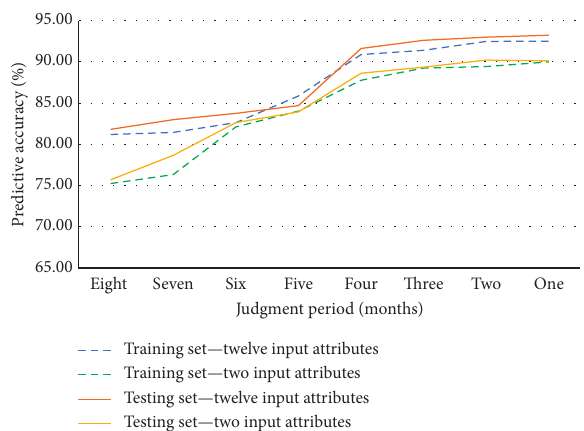
Figure 7: Prediction accuracy under different input properties and judgment